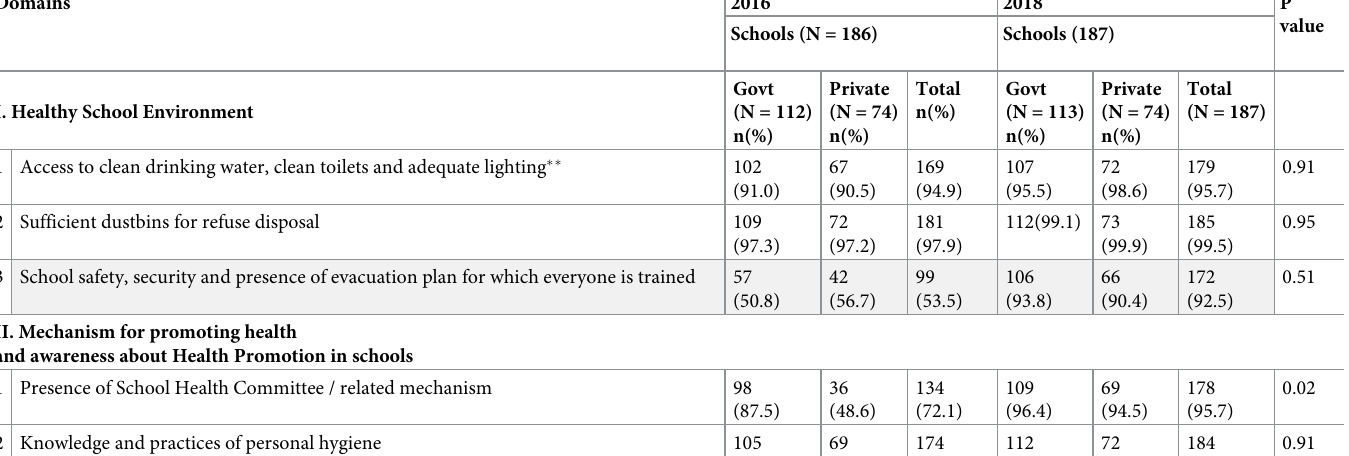
Table 3. Comparison of government and private Schools as per different domains of accreditation as Health Promoting Schools in Chandigarh after intervention (score > 3 ���